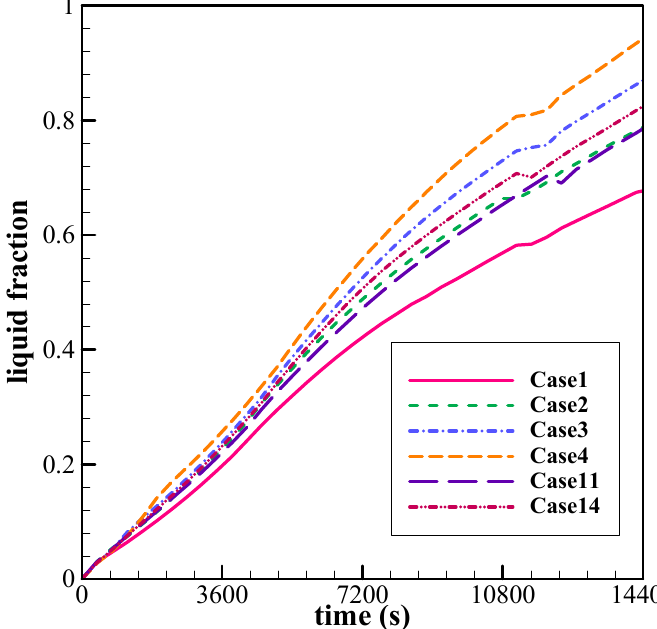
Figure 6. The liquid fraction of the molten PCM over time for different designs of Table 3. Energies 2021 , 14 , x FOR PEER REVIEW